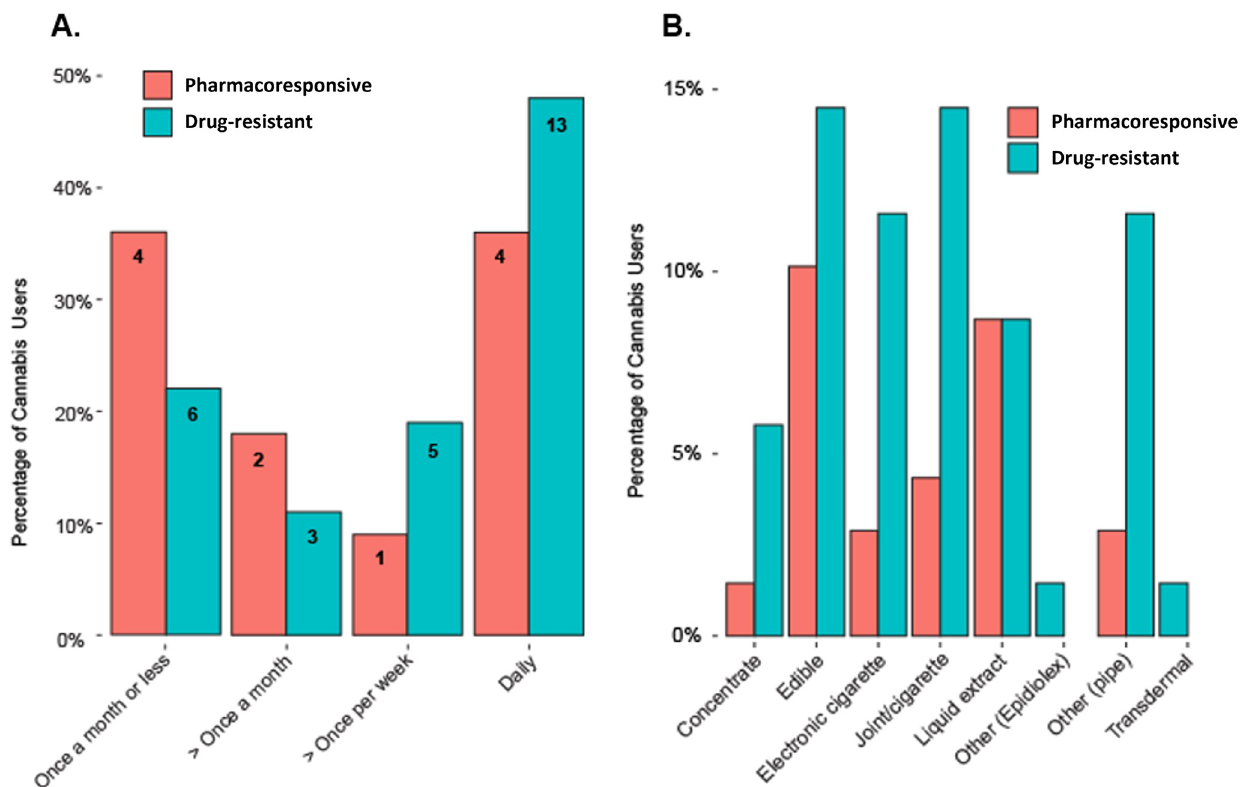
Fig 2. Frequency and method of cannabis use. 2a. Among those who use cannabis, there was a higher proportion of more frequent users in patients with drug-resistant vs. pharmacoresponsive epilepsy. The numbers inside the bars represent the number of patients in each group who used cannabis at a specific frequency. 2b. Comparison of percent of method(s) of cannabis use in participants with drug-resistant and pharmacoresponsive epilepsy.